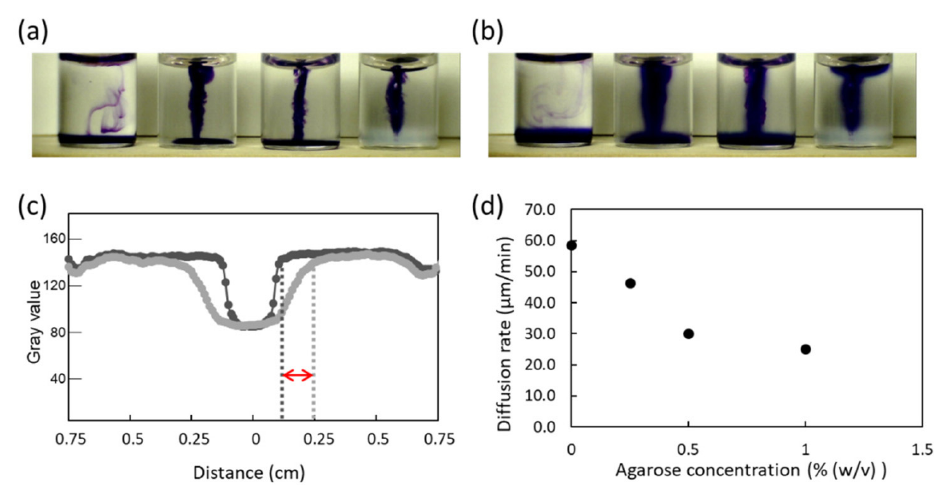
Figure 1. Diffusion of Coomassie Brilliant Blue in agarose gels. ( a , b ) Side views of the vials at immediately after CBB addition ( a ) and 30 min later ( b ). Agarose concentrations of 0, 0.25, 0.5, and 1.0% ( w / v ) from the left. ( c ) The changes in color on the horizontal axis in the presence of agarose (0.5% ( w / v )) at immediately after CBB addition (black circles) and 30 min later (gray circles) determined using ImageJ. ( d ) Relationship between agarose concentration and diffusion